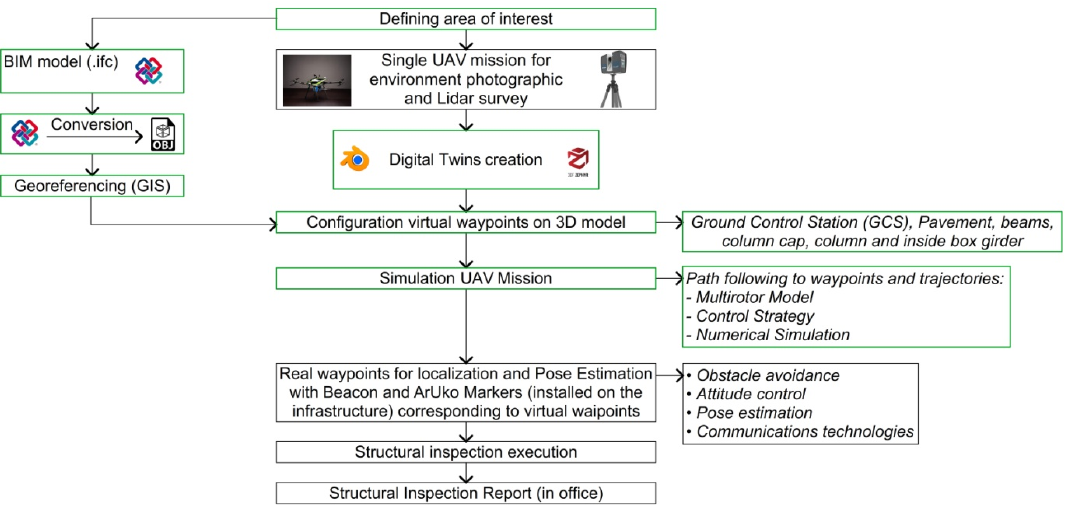
Figure 1. Workflow of the proposed method. The green border represents the parts implemented in this first phase of work.